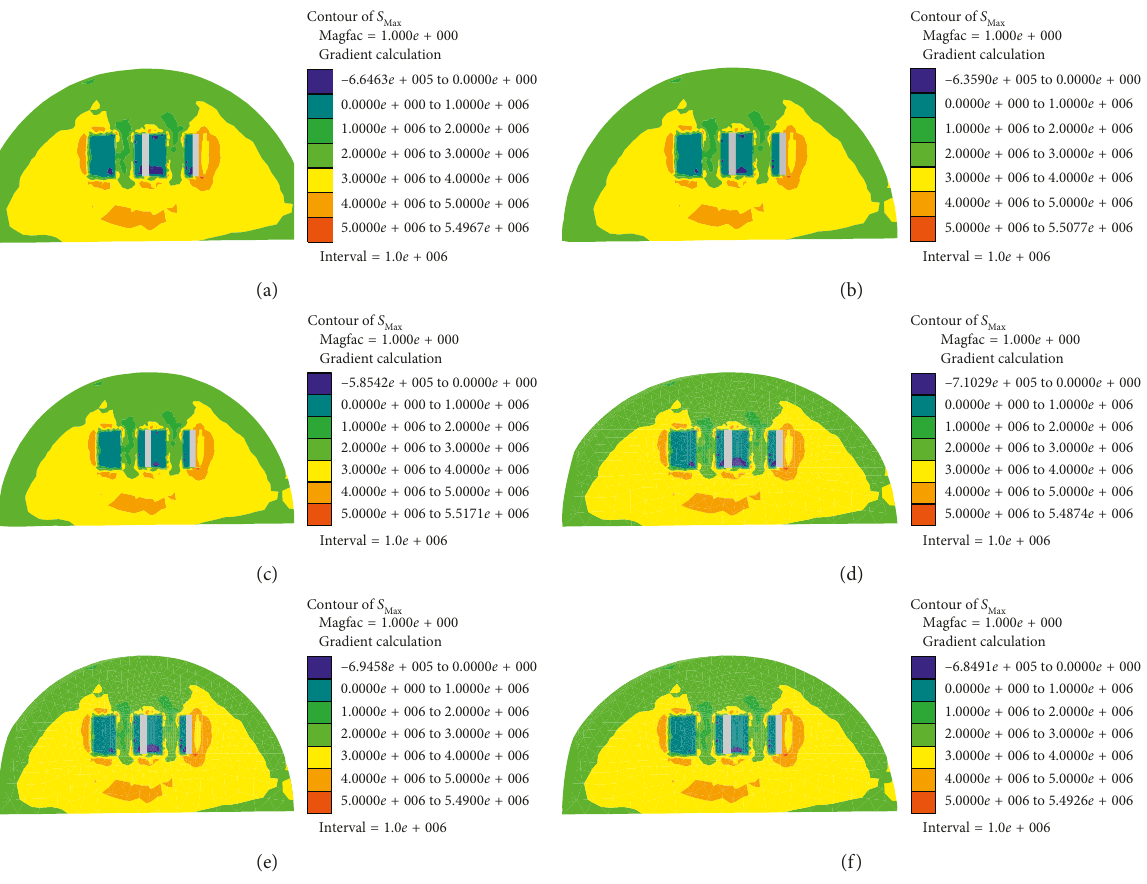
Figure 8: Maximum principal stress cloud: (a) cement-sand ratio 1: 6, backfill concentration 68%; (b) cement-sand ratio 16, backfill concentration 72%; (c) cement-sand ratio 1: 6, backfill concentration 78%; (d) cement-sand ratio 1: 8, backfill concentration 68%; (e) cement-sand ratio 1: 8, backfill concentration 72%; (f) cement-sand ratio 1 :8, backfill concentration